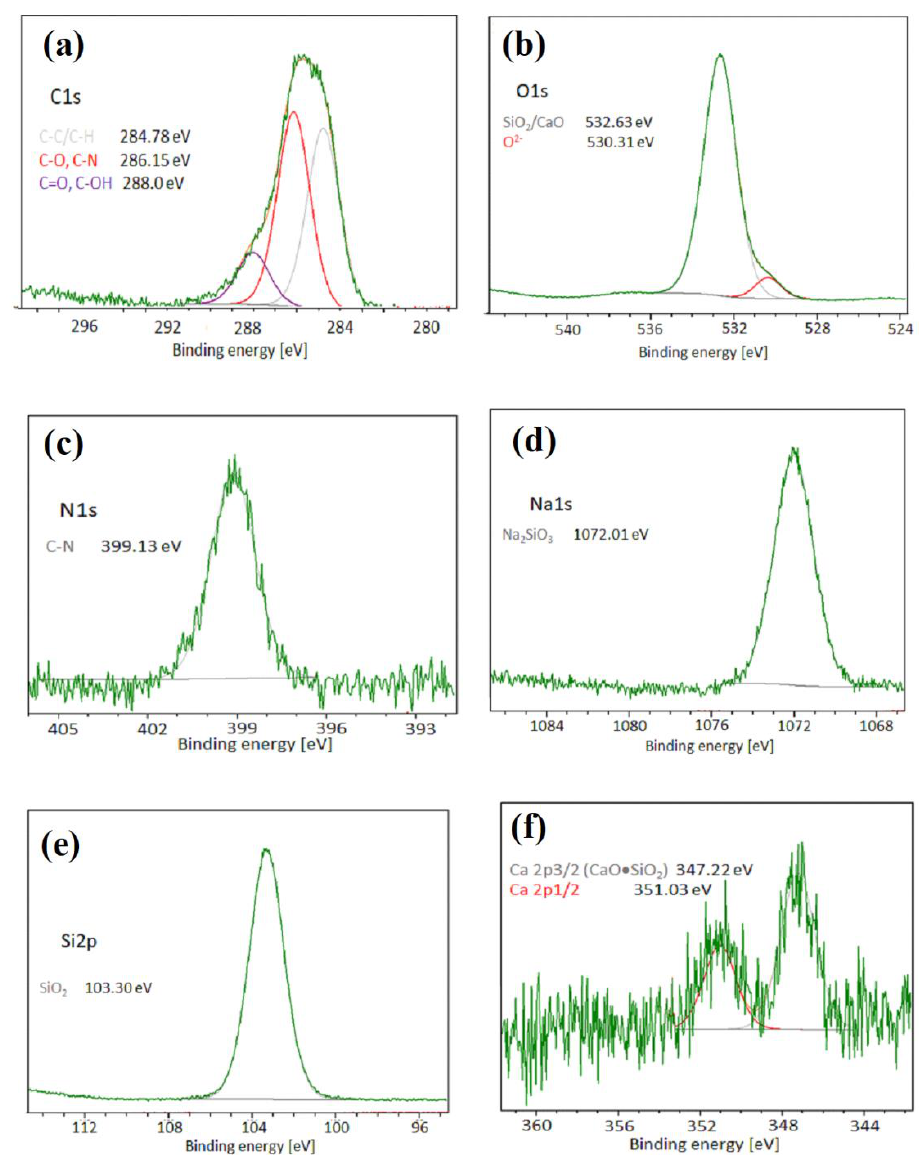
Figure 4. XPS spectra of the Ca-P/chitosan_WG coating deposited on the Mg20Zn alloy: ( a ) C1s, ( b ) O1s, ( c ) N1s, ( d ) Na1s, ( e ) Si2p, and ( f ) Ca2p